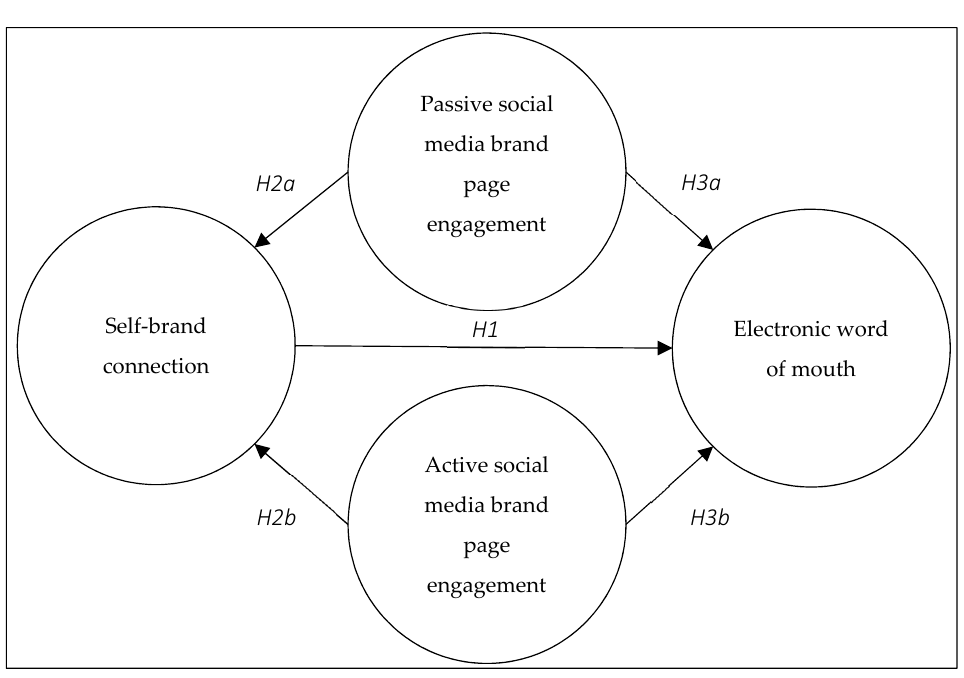
Figure 1. Proposed structural model.